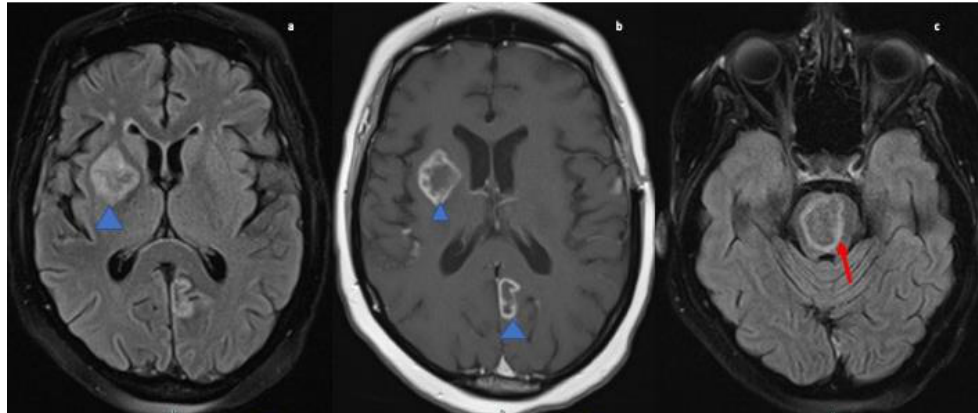
Figure 4. MRI Brain axial fluid-attenuated inversion recovery (FLAIR; ( a )) & T1-weighted post contrast image ( b ) reveals hyperintense lesion in right gangliocapuslar region (blue arrowhead; ( a )) with corresponding heterogenous peripheral ring enhancement, in addition to enhancement in the left paramedian occipital lobe (blue arrow head; ( b )). FLAIR image ( c ) reveals circumscribed intra-axial parenchymal lesion in the pons (red arrow).